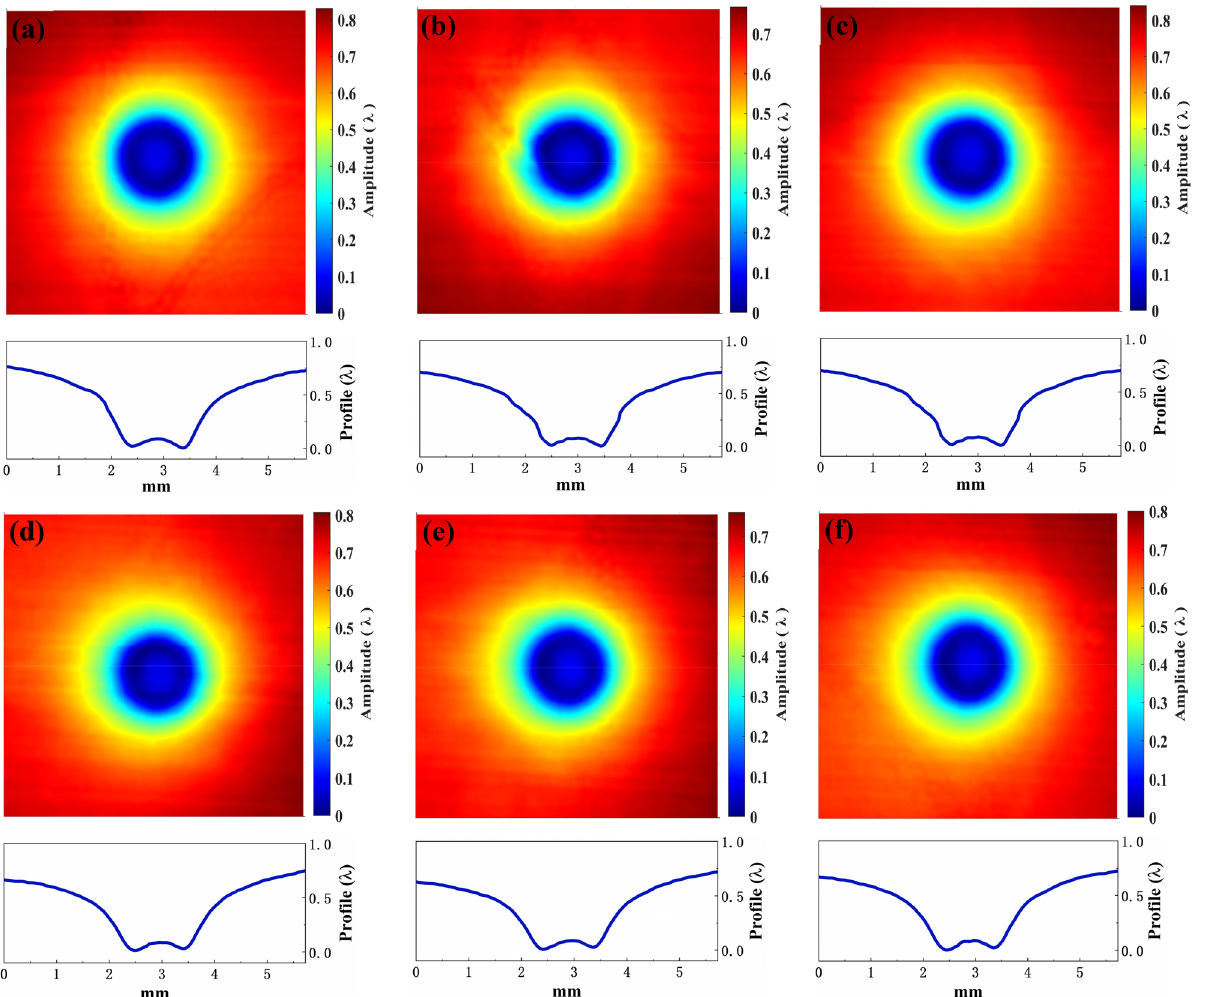
Figure 10. The 3D removal characteristics and corresponded 2D morphology features of jet spots using the BT2 (the time, pressure and nozzle are 1 min, 0.5 MPa and 1 mm, respectively. λ = 632